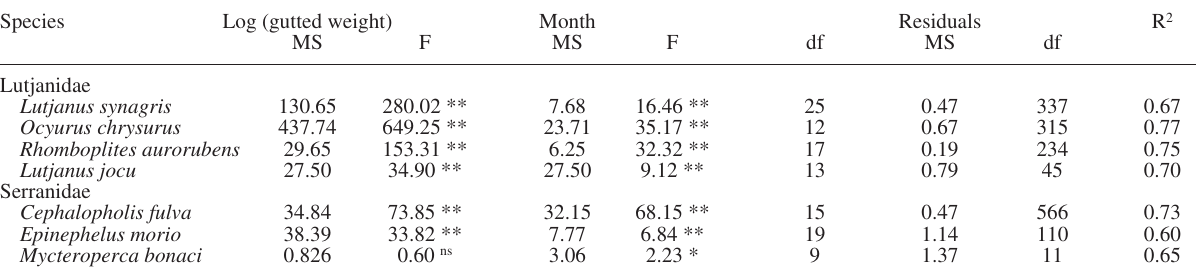
Table 2. – Summary of the ANCOVA results with female log-transformed gutted weight (GW) as covariate, month as the main effect, and log-transformed gonad weight as dependent variable (ns non-significant p>0.10, * p ≤ 0.10, **p ≤ 0.5). Species Log (gutted